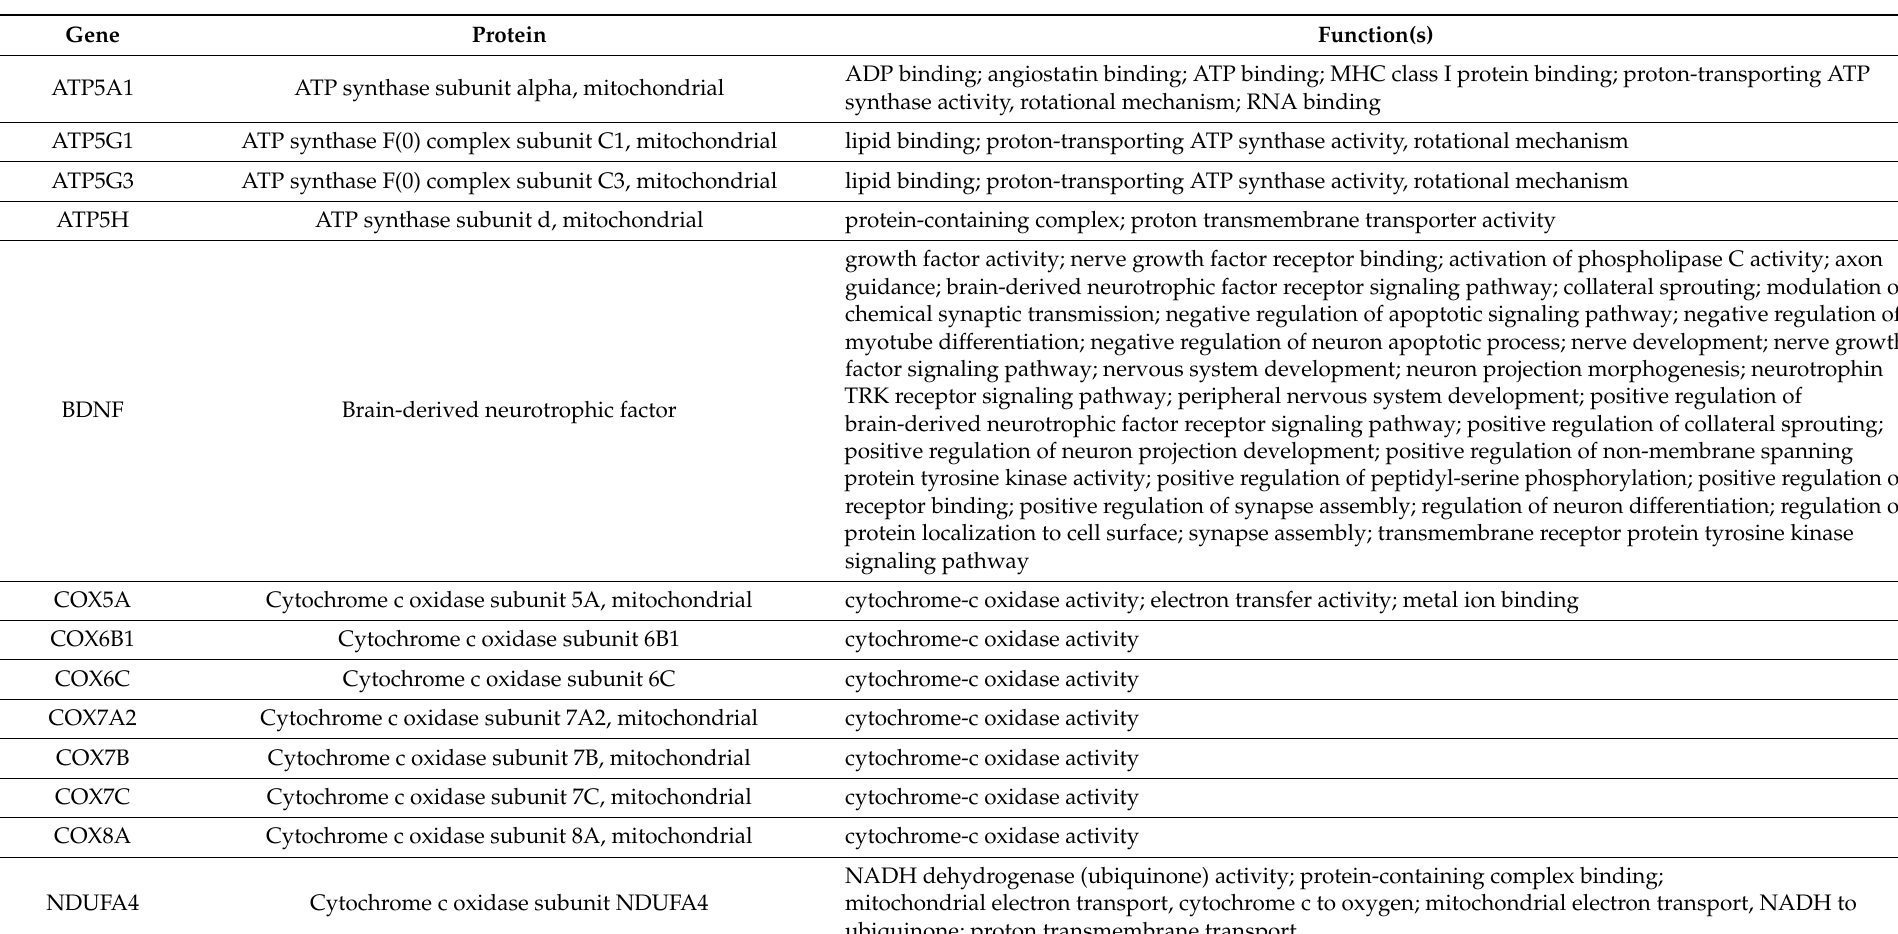
Table 2. HD pathway genes, significantly downregulated in low-fertile buffaloes as reported by Paul et al. [158]. Function(s) of the proteins were taken from